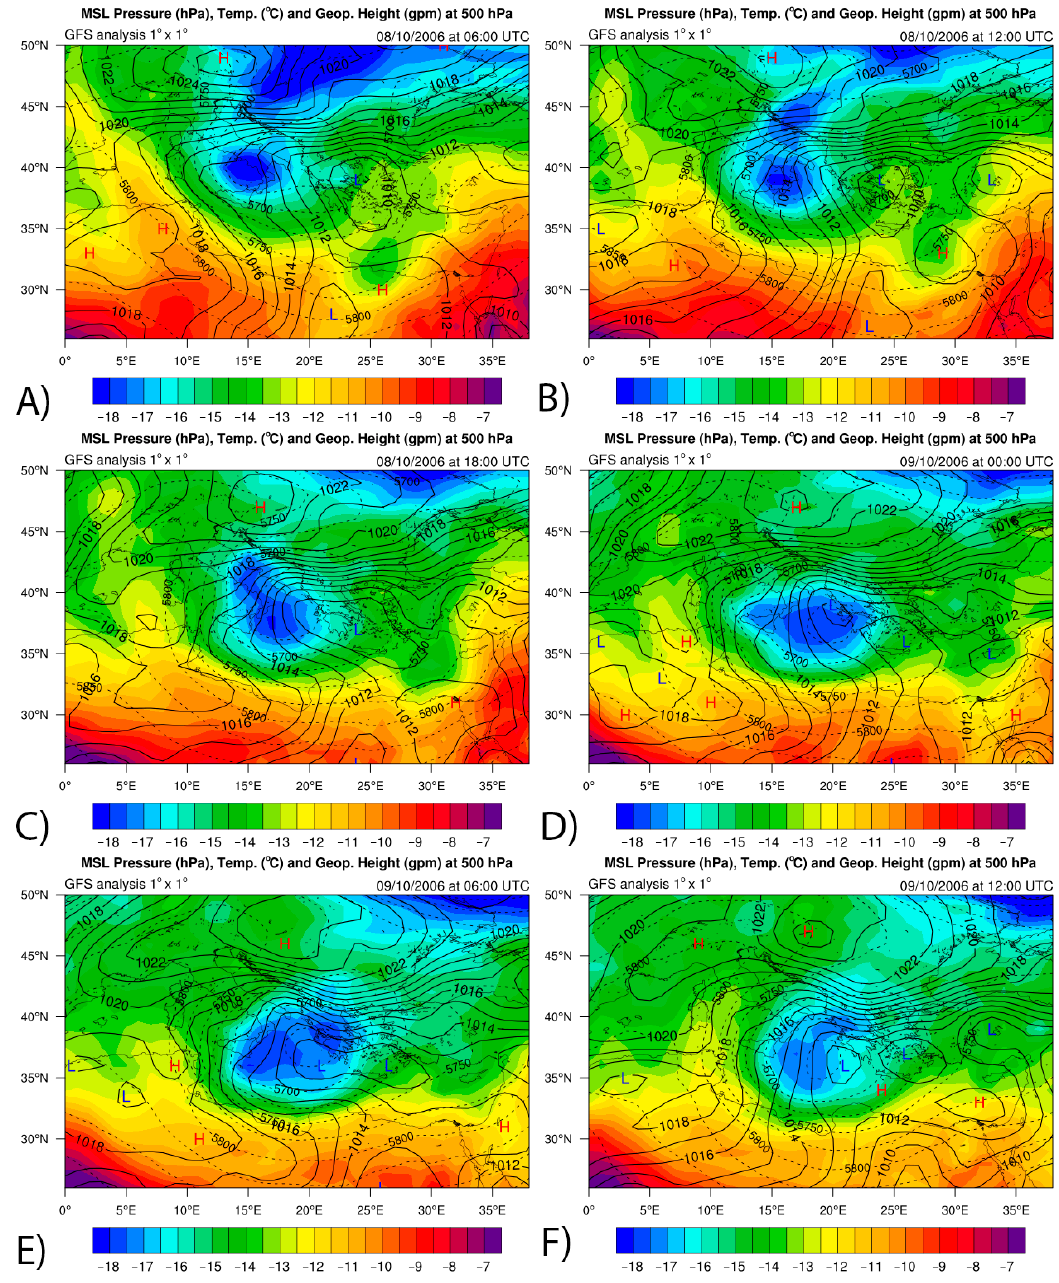
Figure 5. Mean sea level (MSL) pressure (solid black contours in hPa), temperature (colour-shaded in °C), and geopotential height (dashed black contours in gpm) at 500 hPa based on GFS analyses for 8 October 2006 at ( A ) 06:00 UTC; ( B ) 12:00 UTC; ( C ) 18:00 UTC; and for 9 October 2006 at ( D ) 00:00 UTC; ( E ) 06:00 UTC; ( F ) 12:00 UTC.